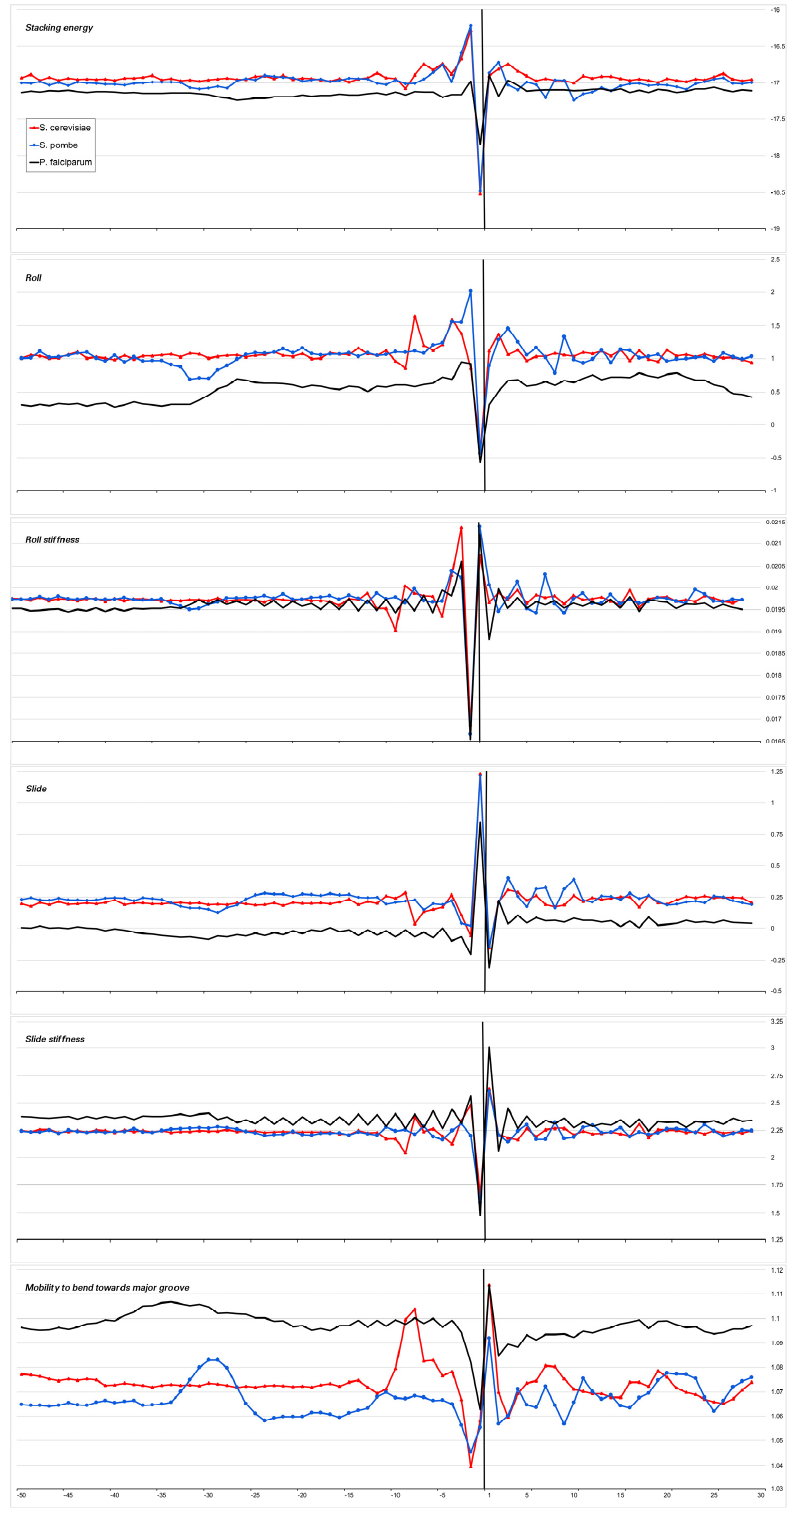
Figure 6. Local variations of the values of physical and structural parameters in core promoter regions of S. cerevisae , S. pombe , and P. falciparum. ( a ) Stacking energy (in kcal/mol). ( b ) Roll (in degrees). ( c ) Stiffness of the duplex structure to Roll alteration (in kcal/mol degree). ( d ) Slide (in angstroms). ( e ) Stiffness of the duplex structure to Slide alteration (in kcal/mol angstrom). ( f ) Mobility to bend towards major groove (in mobility